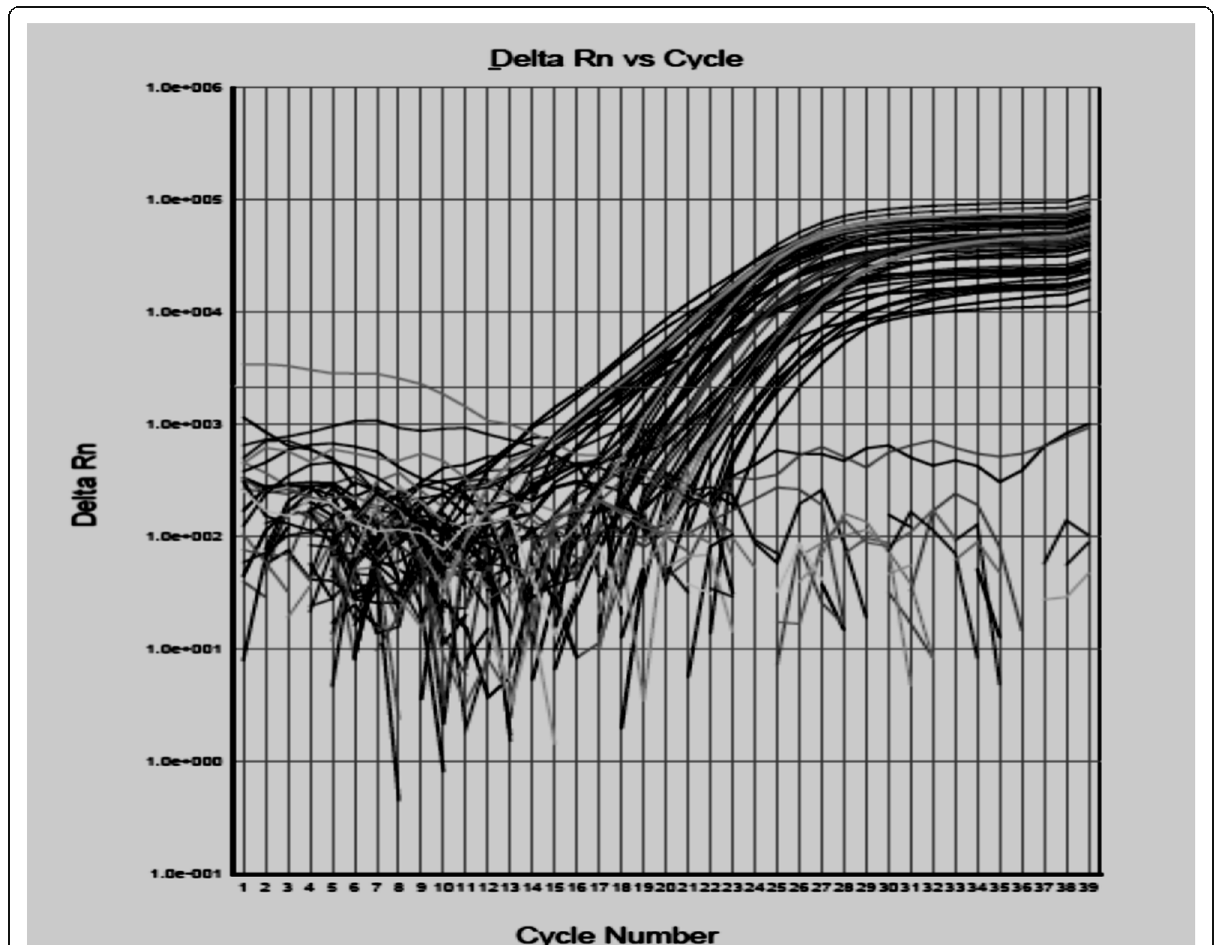
Fig. 3 Real-time PCR output, showing different expression level of PR-1b gene after application of different SCF at 21 Days after virus inoculation (DAVI) against PVY NTN infection. Data is the amplification plot detected by real-time PCR output 7500(Applied Biosystems). The PCR was run for 40 cycles. CT value is the PCR cycle number at which the curve intersects the threshold (horizontal line), where fluorescence meets the threshold in the amplification plot. Undetected was considered negative result, cycle threshold Ct > 30 considered negative while, Ct < 30 considered positive result. Data were collected from the mean values of Ct of two replicated run by real time PCR and the whole experiment was conducted twice